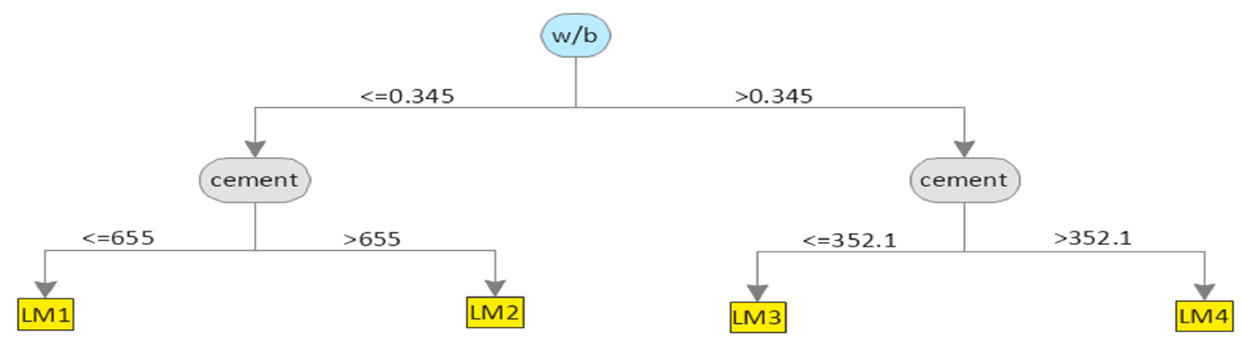
Figure 7. Generated model of the tree structure of M5P for STS. Table 5. Coefficients of the linear models developed by M5P for STS based on Equation (4).